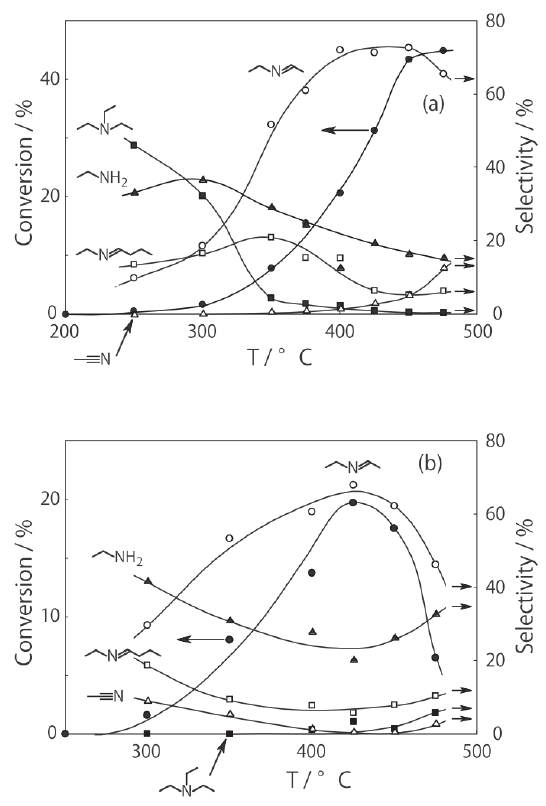
Figure 27. Effect of temperature on reactivity and product selectivity of diethylamine over (H O) [(Mo Cl )Cl ]·6H O in a ( a ) hydrogen; and ( b ) helium stream. Following activation 3 2 6 8 6 2 of the cluster (30 mg, 25 μmol) in the gas stream (600 mL/h) for 1 h, reaction was started by introduction of diethylamine (0.20 mL/h, 1.9 mmol/h) to the stream without changing the temperature. Conversion and selectivities are based on diethylamine at 3 h after reaction